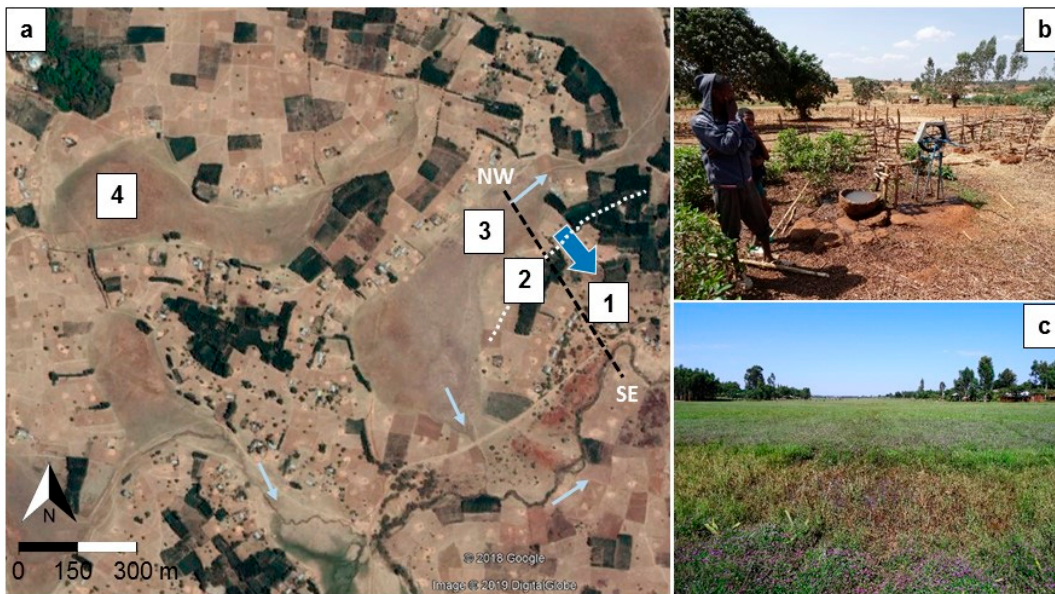
Figure 7. ( a ) Map showing seasonally inundated floodplain dambos with surface water flow directions indicated with thin arrows and shallow groundwater flow indicated by the thick arrow. The dotted line represents the surface flow divide. Locations 1–4 are referred to in the text. The northwest-southeast dashed line is the location of the cross-section in Figure 9. ( b ) Photograph from the 2015 dry season of the perennial well with a rope-and-washer pump at location 1. ( c ) Photograph of a saturated dambo at the end of the 2015 wet season close to location 3.